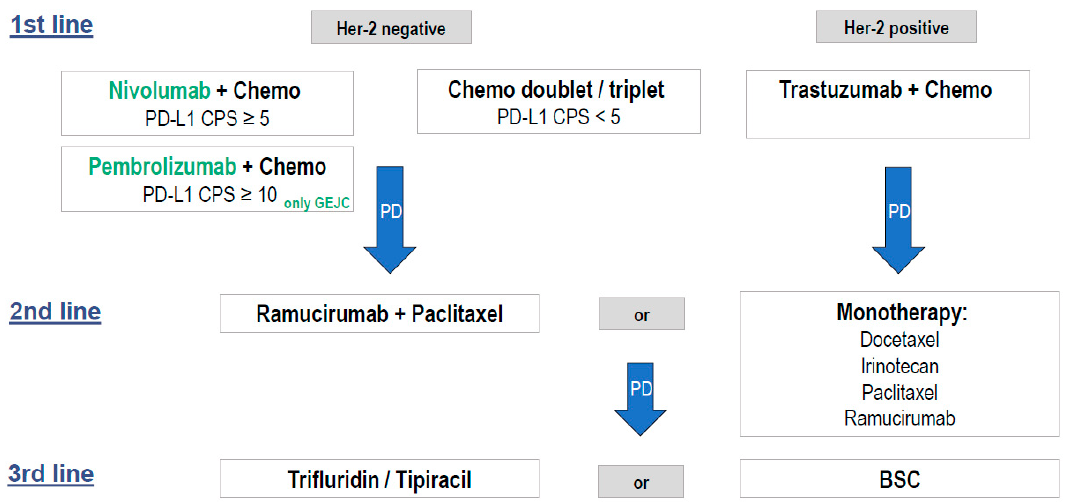
Figure 1. New therapeutic strategies in advanced esophagogastric adenocarcinoma (Europe). Chemo = chemotherapy, PD-L1 CPS = programmed cell death protein 1 (combined positivity score), BSC = best supportive care .